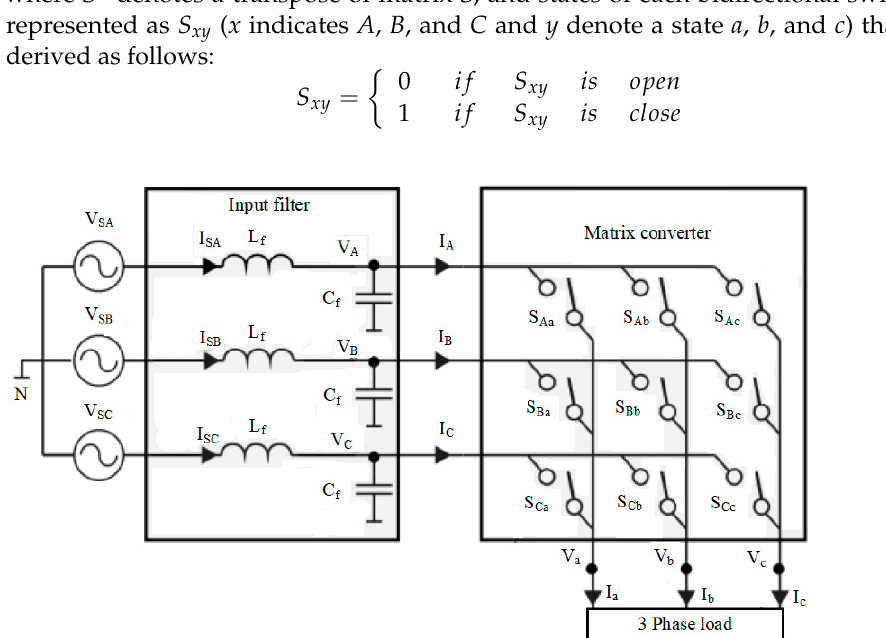
Figure 2. Matrix converter with input filter.